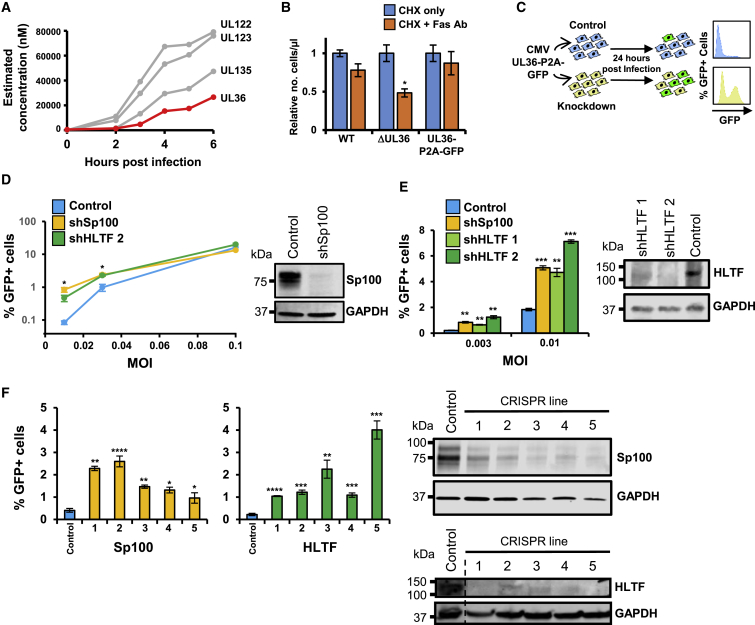
HLTF Restricts Early HCMV Infection(A) Viral proteins with the highest cellular concentration, estimated using a “proteomic ruler” approach (Wisniewski et al., 2014) with data from the 0- to 6-hr pSILAC experiment. A UL123 C-terminal GFP tag impaired viral growth. A similar problem occurred with UL135 (data not shown). The inhibitor of apoptosis UL36, which was the fourth most abundant viral protein, was therefore selected and C-terminally tagged with a self-cleaving P2A peptide followed by EGFP.(B) A C-terminal UL36-GFP tag does not impair protein UL36 function. Cells were infected with the indicated virus for 24 hr, then treated with cycloheximide (CHX) and a crosslinking Fas antibody. A viability dye was used to quantify live cells by flow cytometry. Data were normalized to the number of live cells in the absence of Fas antibody. UL36-P2A-GFP virus was comparable with wt, whereas virus lacking UL36 was significantly more sensitive to Fas-mediated apoptosis. ∗p < 0.05 by two-way ANOVA (n = 3).(C) Schematic of the restriction assay. HFFF-TERTs were infected at low MOI after stable knockdown for a putative restriction factor or control.(D) Validation of the restriction assay using shRNA. Representative results from one of four experiments are shown (left panel). At MOI = 0.1, a difference between shSp100 and shControl cells was no longer detectable, suggesting that the antiviral activity of Sp100 was efficiently overcome. In the same experiment, HLTF restricted infection similarly to Sp100. Values shown are mean ± SEM p values for a difference between shSp100 or shHLTF, and control cells were estimated using a two-tailed t test (n = 3). ∗p < 0.05 (for both Sp100 and HLTF where indicated). Immunoblot confirmed knockdown of all Sp100 isoforms (right panel) and HLTF (E).(E) HLTF restricts early HCMV infection. Application of the restriction assay at low MOI using two different shHLTF vectors suggested that HLTF restricted infection at least as potently as Sp100 (left panel). p values were estimated using a two-tailed t test (n = 3). ∗∗p < 0.005, ∗∗∗p < 0.0005.(F) Confirmation that HLTF restricts early HCMV infection using five independent polyclonal CRISPR/Cas9 Sp100 and HLTF cell lines. Each employed integrated guide RNAs (gRNAs) with different target sequences within a given gene. Control cells expressing non-targeting gRNAs were generated in a similar manner (right panels; superfluous lanes from the HLTF and corresponding GAPDH gel have been digitally eliminated as indicated by the dashed line). Infection at MOI = 0.01 identified a substantial increase in viral replication in knockdown compared with control cells (left panels). p values were estimated using a two-tailed t test (n = 3). ∗p < 0.05, ∗∗p < 0.005, ∗∗∗p < 0.0005, ∗∗∗∗p < 0.00005.